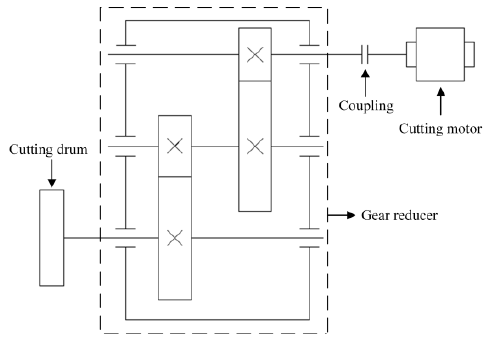
Figure 2. Schematic diagram of the cutting power system.